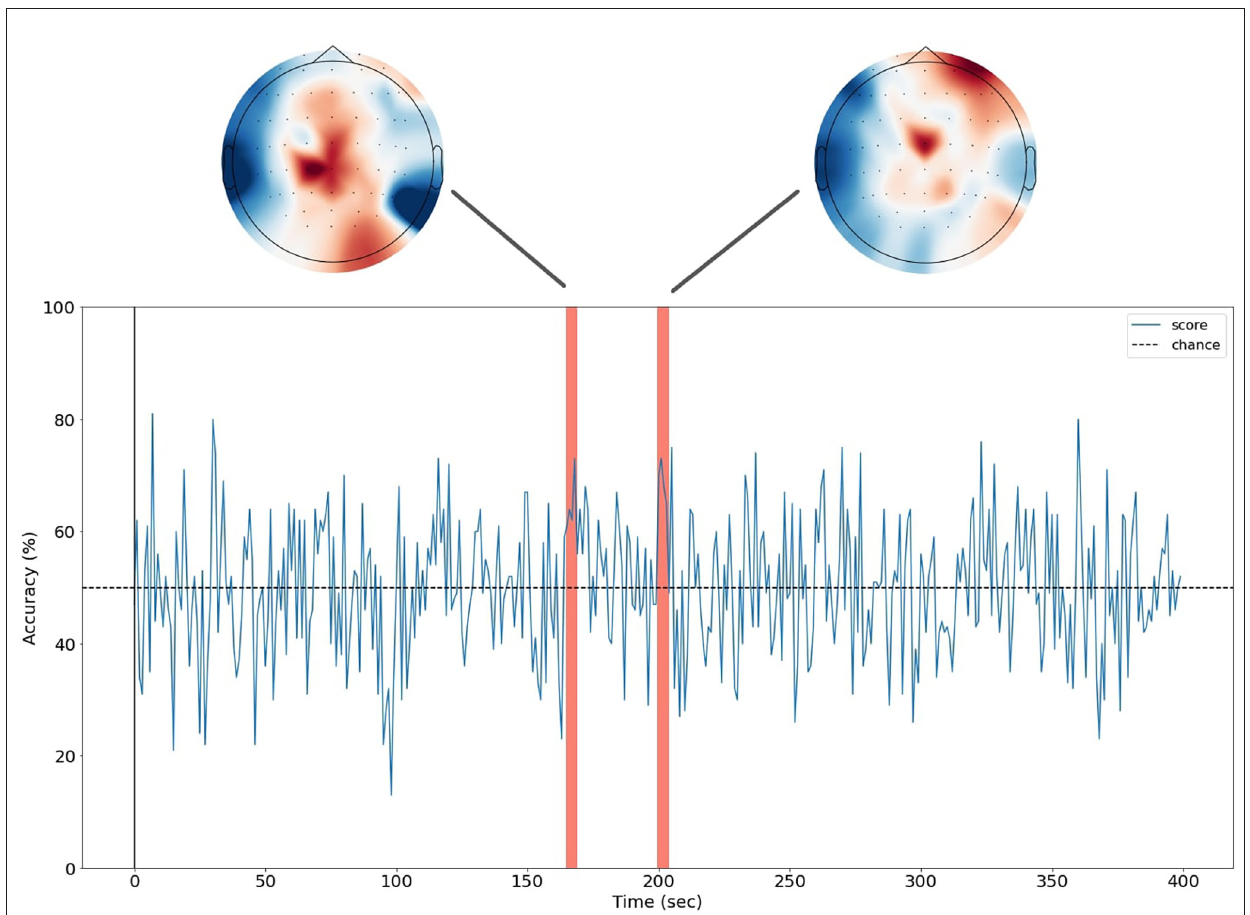
FIGURE4 Spatio-temporal decoding of the delta of WTP for sugar-containing food. A machine learning logistic regression was used to predict the delta of WTP for sugar-containing products (binary variable) based on distributed patterns of EEG responses to the healthy eating call. The blue line denotes the classification accuracy for each time window. A horizontal dashed line has been added at 50% as a reference, although statistical testing was performed based on permutations. The red bars indicate the clusters where the classification accuracy was statistically significant after a cluster- based correction for multiple comparisons. The feature weights of the classifiers in the significant cluster windows have been added at the top of the plot. These are the standardized activation